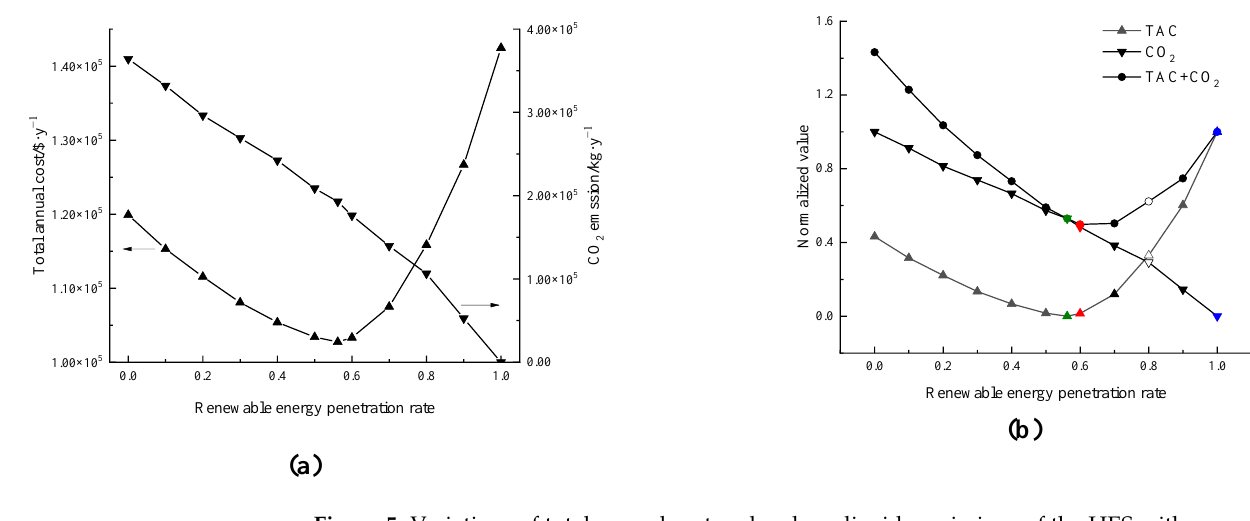
Figure 5. Variations of total annual cost and carbon dioxide emissions of the HES with renewable energy penetration rate. ( a ) Variations of the total annual cost and carbon dioxide emissions with renewable energy penetration rate, ( b ) Variations of normalized total annual cost and normalized carbon dioxide emissions with renewable energy penetration rate.